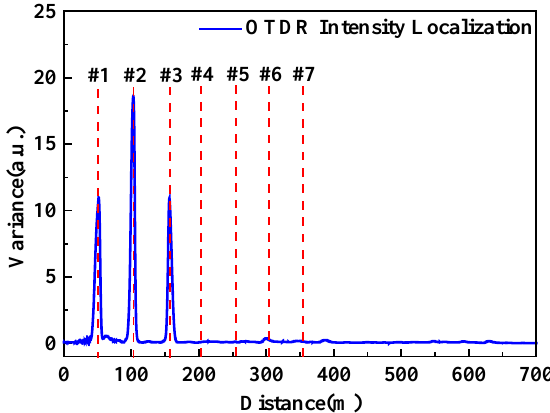
Figure 7. Intensity localization signal of breakdown discharge.